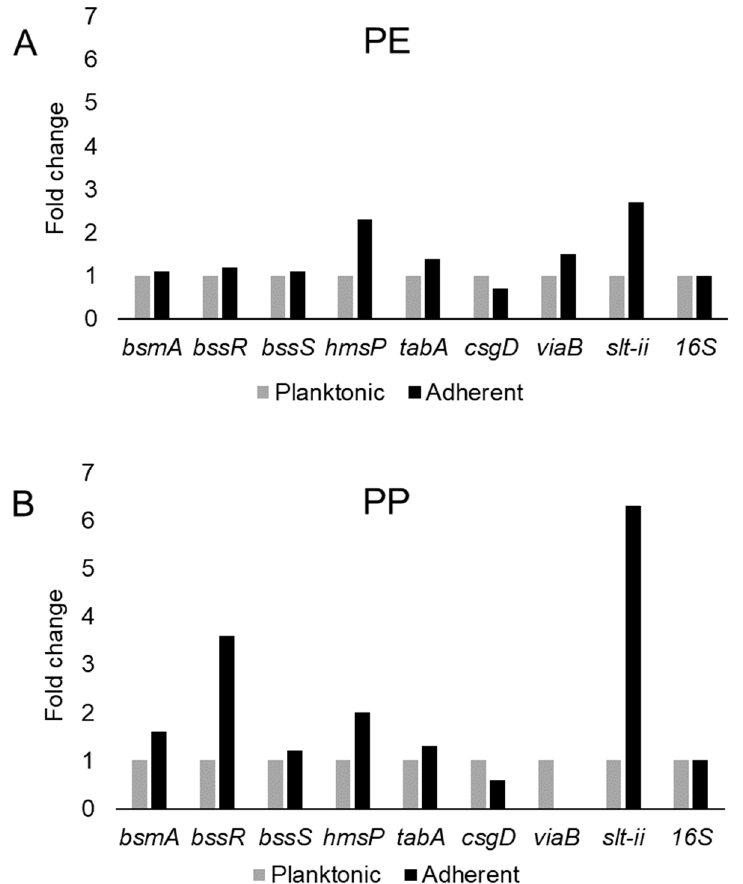
Figure 4. Variation in gene expression during planktonic and adherent growth of C. freundii in tryptic soy broth on polyethylene (PE) surface as shown in ( A ) and polypropylene (PP) surface as shown in ( B ), respectively. The 16S rRNA gene expression was used as an internal control.